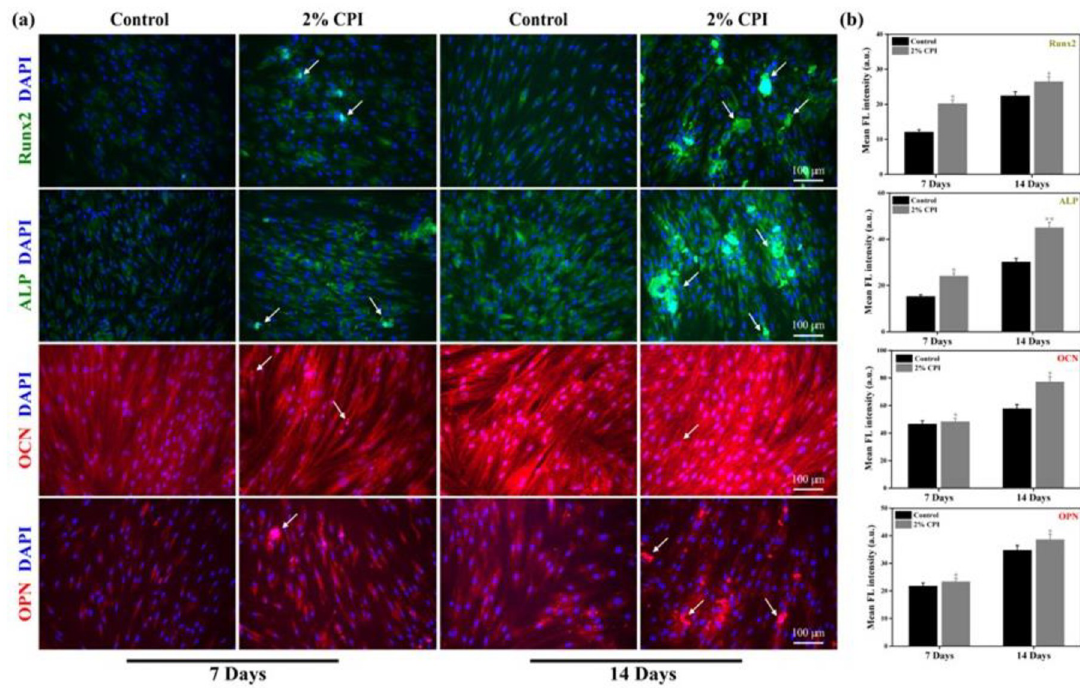
Fig 9. Osteoblast-specific protein markers expression of CPI treated hBMSCs at indicated time intervals. (a) Fluorescence microscopy images of respective protein markers (scale bar: 100 μ m), and (b) corresponding fluorescence intensities. Data are mean ± SD of triplicated experiments, statistical significance at � p < 0.05 and �� p < 0.01, respectively. White arrow indicates the presence of CPI on to the surface of hBMSCs.